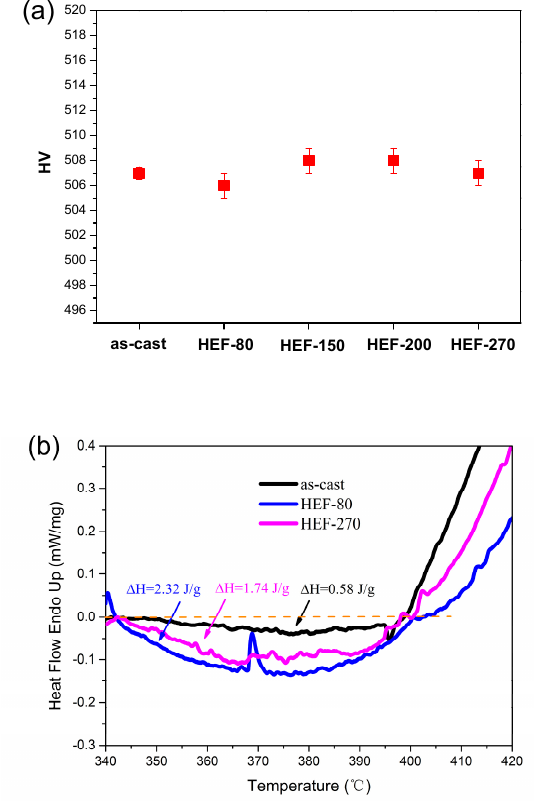
Figure 10. ( a ) Comparison of microhardness of the as-cast and HEF-treated samples and ( b ) comparison of relaxation enthalpies of the as-cast and HEF-treated samples.